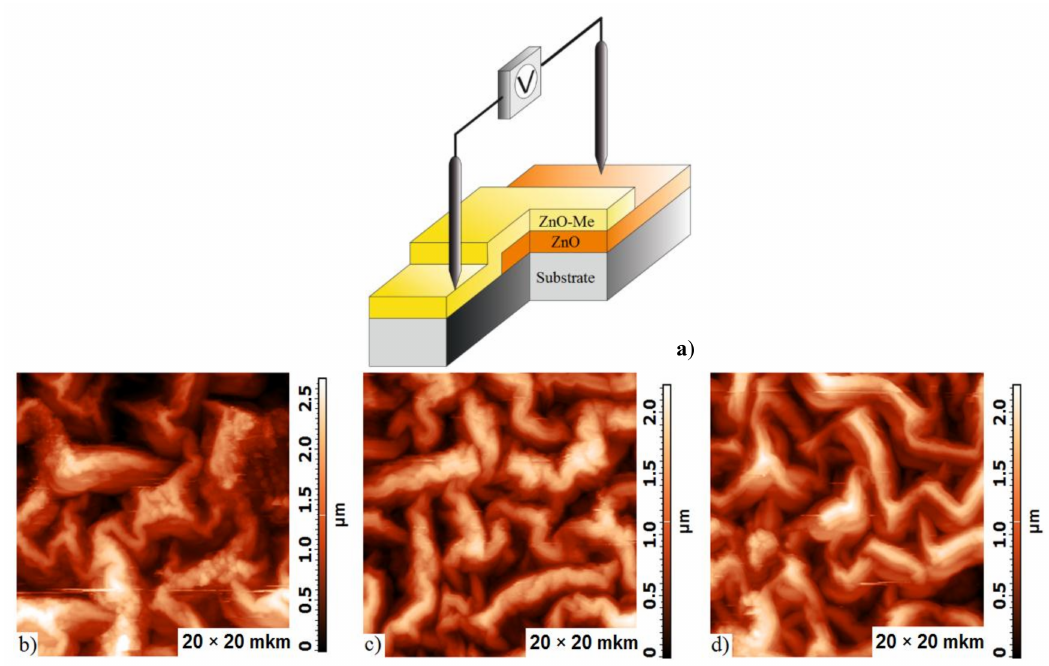
Figure 1. A scheme of the experiment ( a ); surface morphology of ZnO ( b ); ZnO–Fe ( c ); and ZnO–Cu ( d )